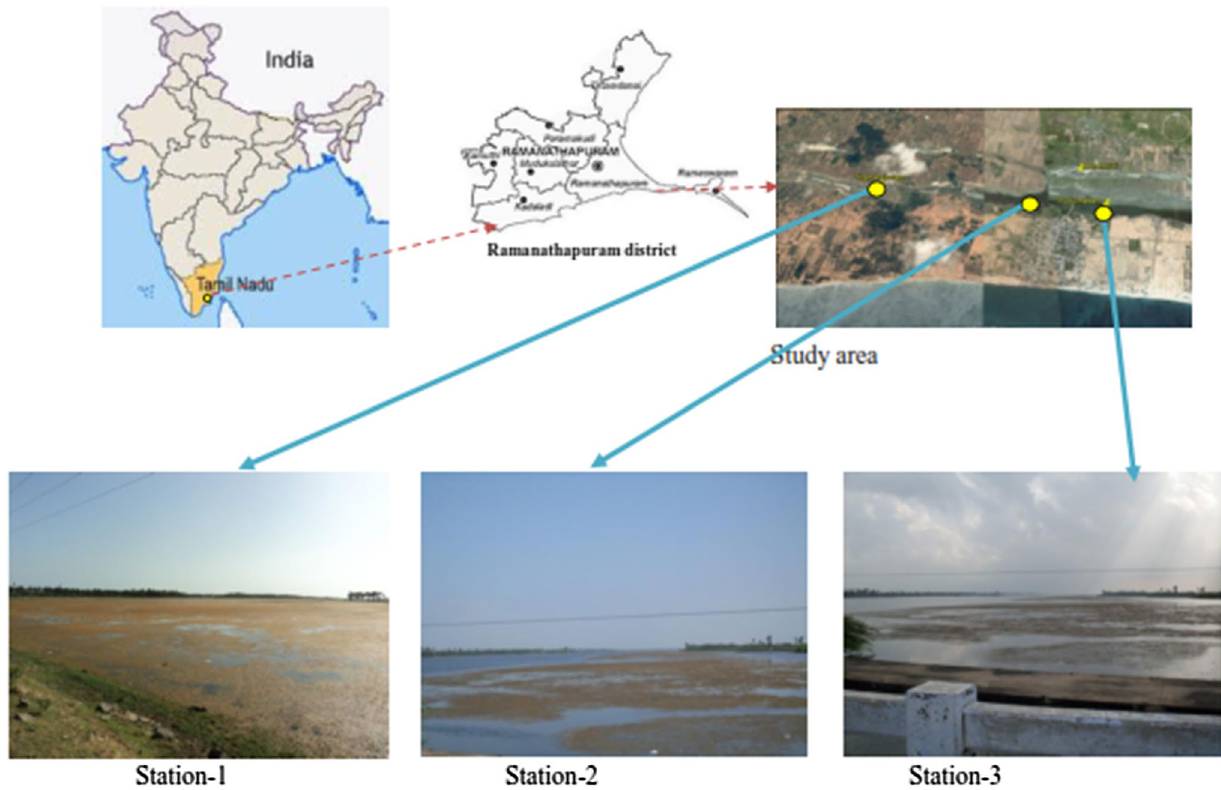
Fig. 1 Sampling stations in Tharavai wetland, Ramanathapuram district of